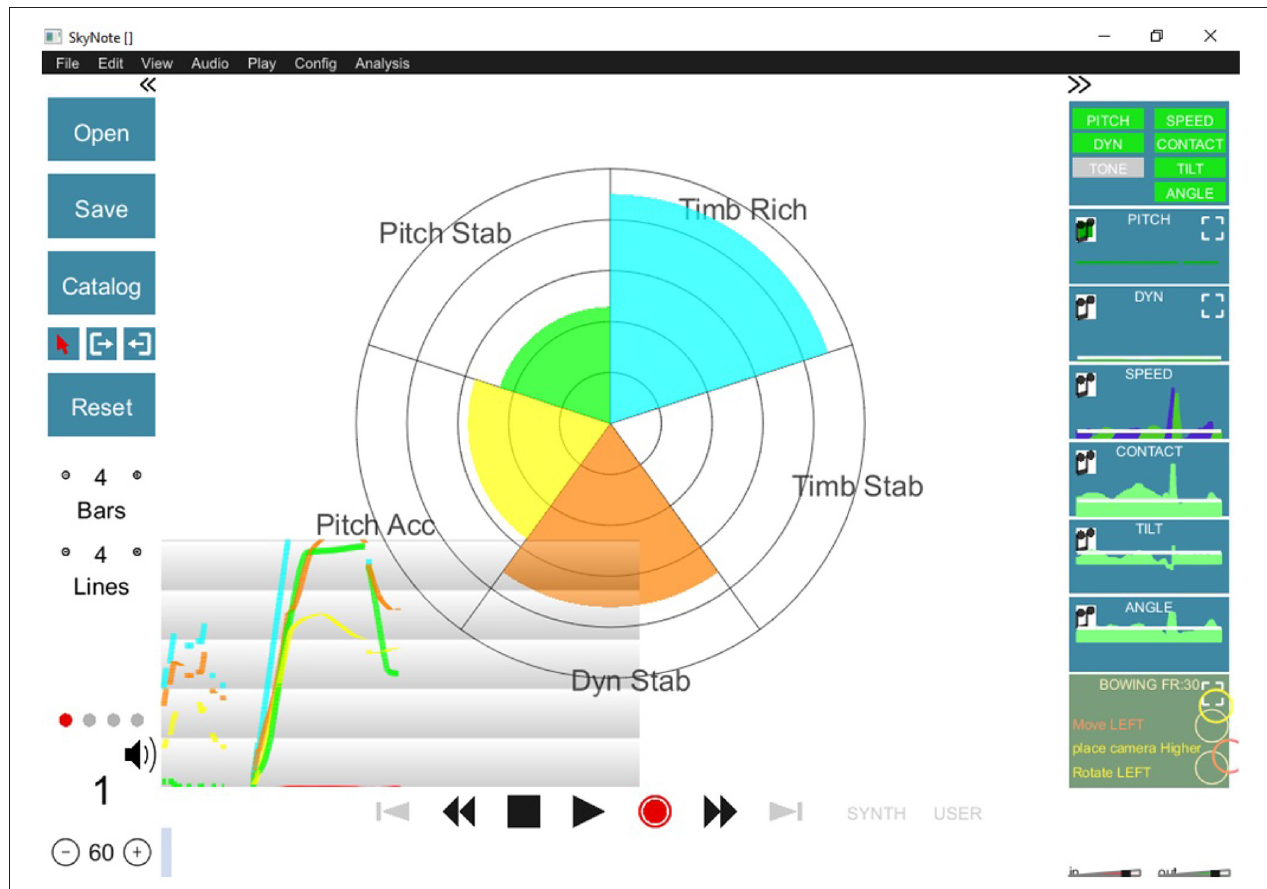
FIGURE 2 | Visual display of the tool used to offer real-time sound quality feedback to participants. Each portion of the spider chart represents a different sound feature while its amplitude represents how close the participant was to the ideal sound.